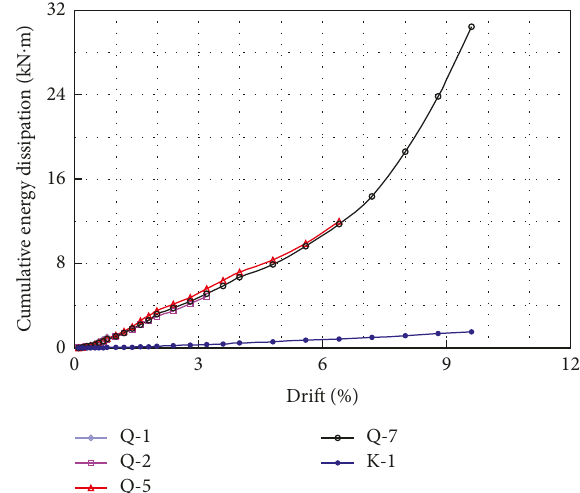
Figure 9: Comparison of cumulative energy dissipation of